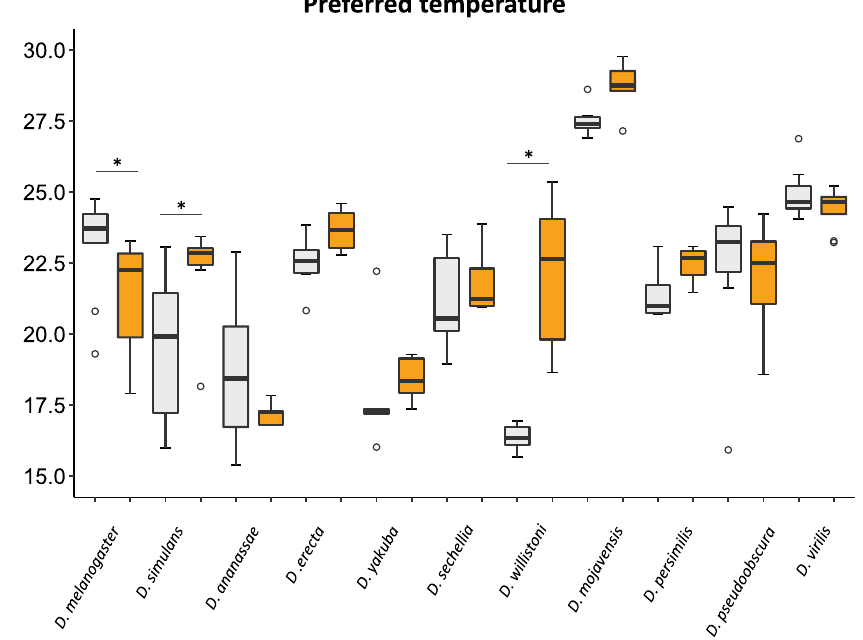
Figure 8. Effects of the antenna ablation on preferred temperatures. Preferred temperatures in control (gray box) and antenna ablated (orange box) flies are shown. Horizonal bars with * above the box indicate significant difference between control and antenna ablation flies (Mann–Whitney U tests: p <